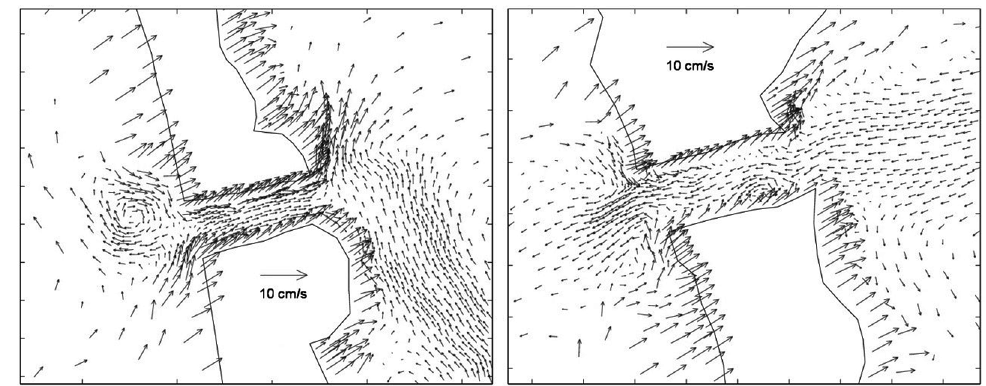
Figure 7. The residual current vectors near the southern (left) and northern (right) inlets after the first 9 days of the simulations